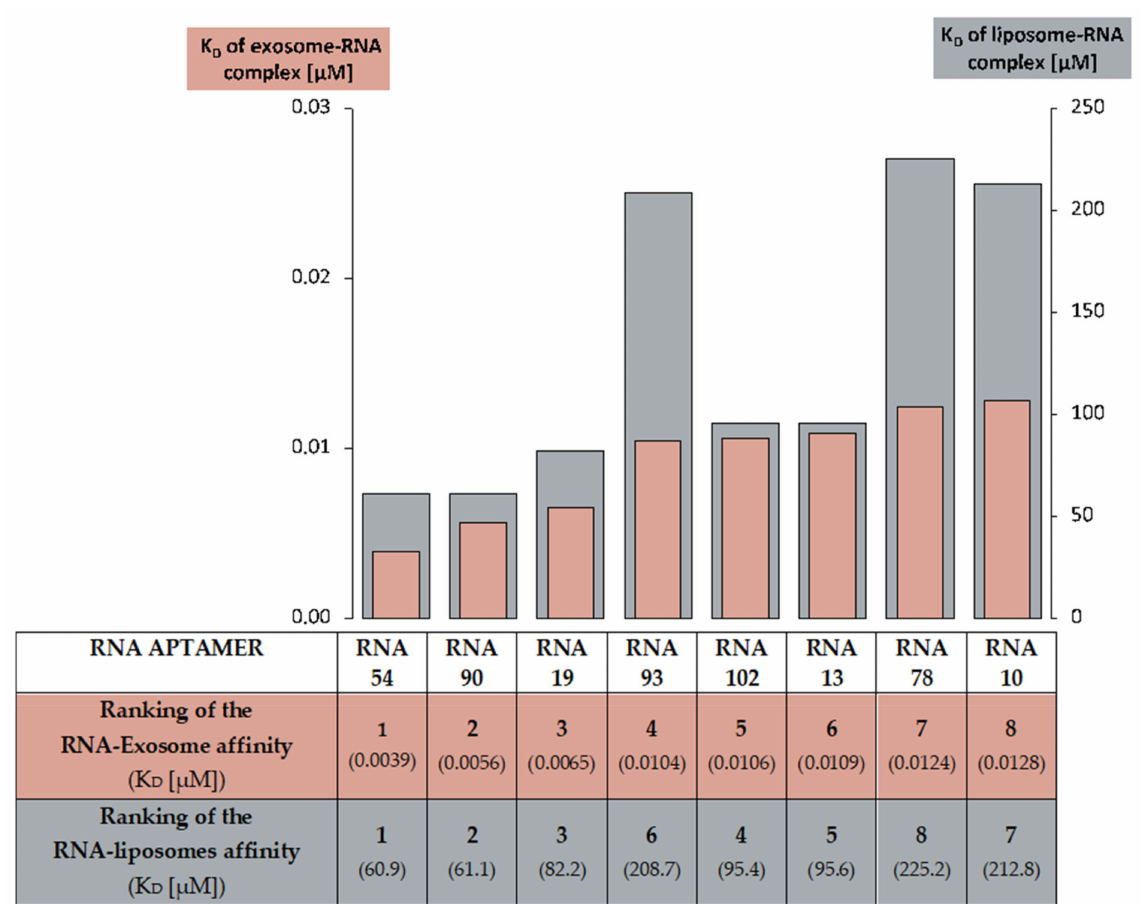
Figure 6. A comparison of the RNA aptamer affinity to raft liposomes and to exosomes. The ranking of RNA-to-raft liposomes affinity was based on the RNA-liposome complex K D calculations. The ranking of RNA-to-exosomes affinity was based on K D for the RNA-exosome